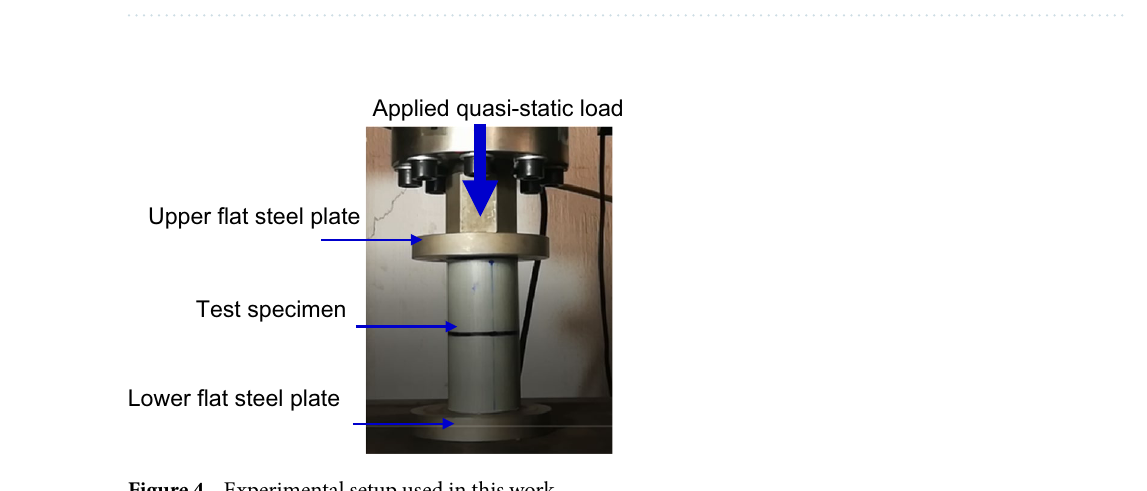
Table 3. Geometrical descriptions of the fabricated metal-composite hybrid pipes. a Cost of the specimen divided by the cost of Al-specimen.